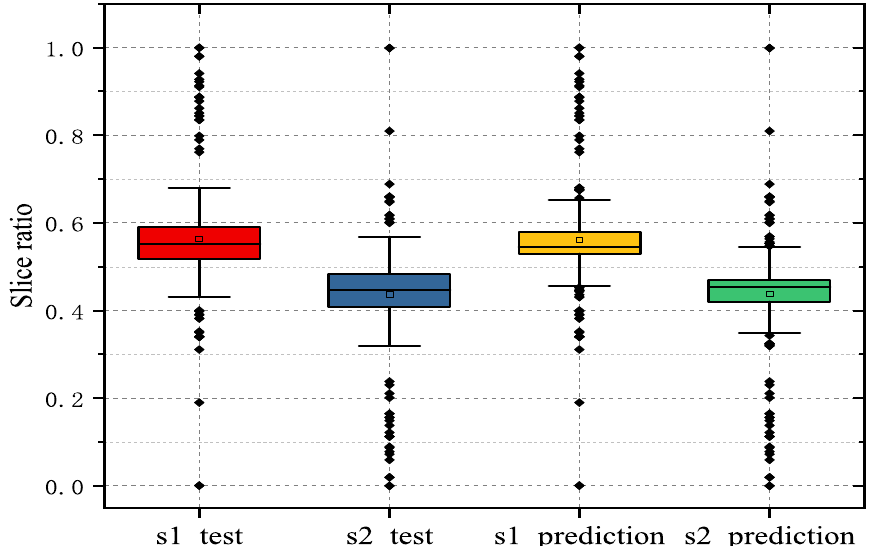
Figure 7. The slice ratio distribution of test and prediction.